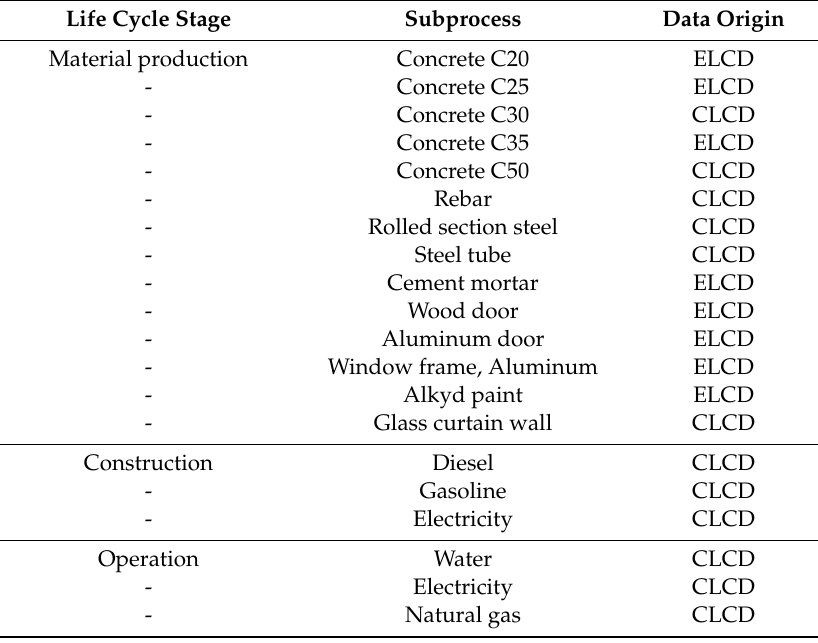
Table 2. Data sources of the